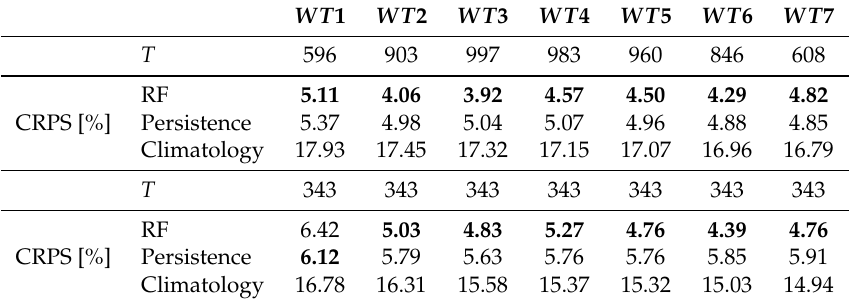
Table 1. Average continous ranked probability score (CRPS), in % of the nominal capacity ( P n ), of the five-minute ahead power forecasts for the seven wind turbines evaluated. Results are shown for the remote sensing-based forecast (RF), persistence and climatology benchmarks. Upper row presents the results for all available measurements ( T ) of each wind turbine. Lower row provides the results for all simultaneous available measurements. Minimum values are shown in